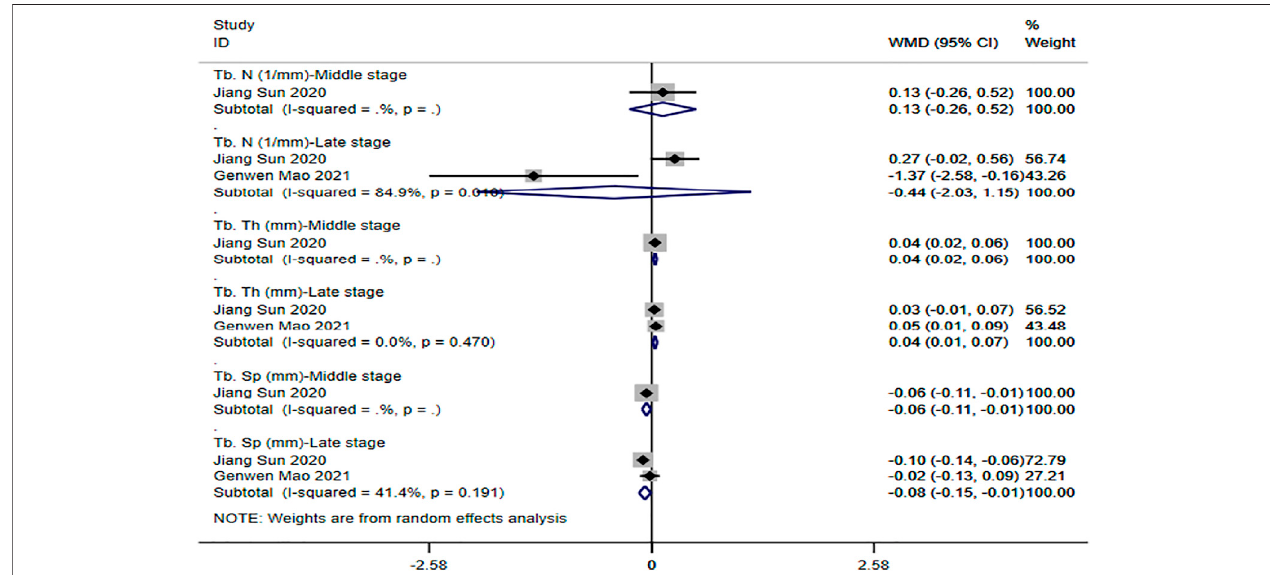
FIGURE 5 | Meta-analysis results of outcome indicators related to new bone formation of magnesium and its alloys vs. titanium and its alloys.